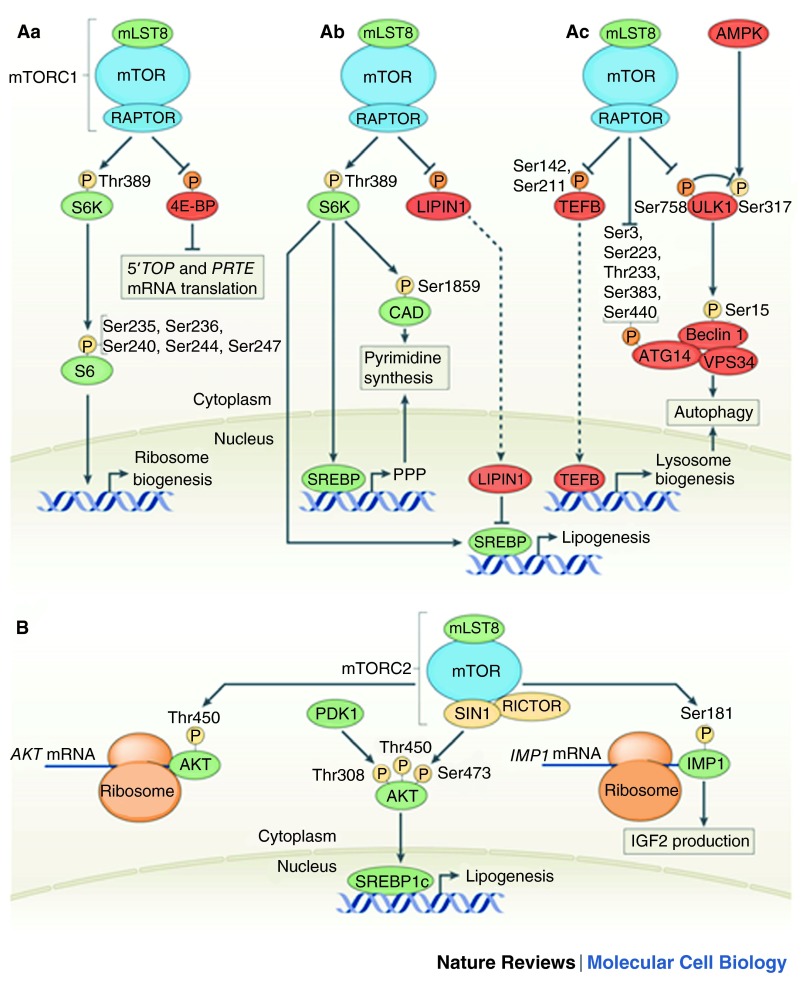
mTOR controls metabolism.Mammalian TOR complex 1 (mTORC1) promotes anabolic processes, such as the biosynthesis of proteins, nucleotides and lipids, and inhibits catabolic processes such as autophagy.
Aa | mTORC1 phosphorylates (P) the hydrophobic motif (Thr389) in ribosomal S6 kinase (S6K), thereby activating it to subsequently phosphorylate ribosomal protein S6 at the sites indicated to promote ribosome biogenesis. mTORC1 also phosphorylates eIF4E-binding protein (4E-BP) at multiple sites to inhibit it. Inhibition of 4E-BP stimulates translation initiation, especially of 5′ oligopyrimidine tract (termed a 5′ TOP) and pyrimidine-rich translational element (PRTE) containing mRNAs.
Ab | mTORC1 stimulates nucleotide and lipid synthesis. mTORC1 promotes the gene expression of key enzymes in the pentose phosphate pathway (PPP), at least in part by activating sterol regulatory element-binding proteins (SREBPs). mTORC1 also stimulates CAD (Gln-dependent carbamoyl-phosphate synthase, Asp carbamoyltransferase, dihydroorotase) by S6K-mediated phosphorylation at Ser1859, which leads to CAD activation and the stimulation of de novo pyrimidine synthesis. Furthermore, mTORC1 promotes lipogenic gene expression by activating S6K or by inhibiting the nuclear translocation of LIPIN1, both of which activate the transcription factor SREBP.
Ac | mTORC1 inhibits autophagy by phosphorylating UNC-51-like kinase 1 (ULK1) at Ser758 and ATG14 at multiple sites. During mTORC1 inhibition, AMPK phosphorylates ULK1 at Ser317, and thereby activates ULK1, which phosphorylates Beclin 1 in the vacuolar protein sorting 34 (VPS34)–Beclin 1–ATG14 complex to initiate autophagy. mTORC1 also inhibits autophagy indirectly by blocking lysosome biogenesis, by phosphorylating and inhibiting the nuclear translocation of transcription factor EB (TFEB).
B | mTORC2 co-translationally phosphorylates AKT at Thr450 to prevent its ubiquitylation and degradation. mTORC2 also post-translationally phosphorylates ATK at Ser473 to promote lipogenic gene expression by activation of SREBP1c. Moreover, mTORC2 co-translationally phosphorylates IGF2 mRNA-binding protein 1 (IMP1) at Ser181, which stimulates insulin-like growth factor 2 (IGF2) production. The activity of proteins shown in green is promoted by mTOR. The activity of proteins shown in red is inhibited by mTOR. Phosphorylation depicted in yellow is an activation signal and phosphorylation depicted in red is an inhibitory signal. Dashed arrows represent translocation of the protein. mLST8, mammalian lethal with SEC thirteen 8; PDK, phosphoinositide-dependent kinase 1; RAPTOR, regulatory-associated protein of mTOR; RICTOR, rapamycin-insensitive companion of mTOR; SIN1, SAPK-interacting 1.This figure has been reproduced with kind permission from Shimobayashi M, Hall M. Making new contacts: the mTOR network in metabolism and signalling crosstalk. Nature Reviews Molecular Cell Biology 2014;15:155–162.